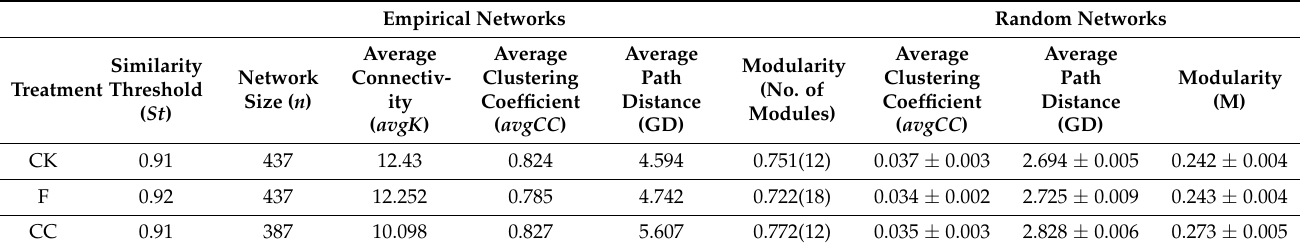
Figure 6. Ecological network graph of CK ( A ), F ( B ), and CC ( C ) treatments. Nodes’ colors represent the different phyla. The red edges represent a positive relationship between two nodes, and blue ones show a negative interaction. The size of nodes indicates the size of node degree. Table 3. Major topological properties of the empirical molecular ecological networks (MENs) of the microbial communities and their associated random